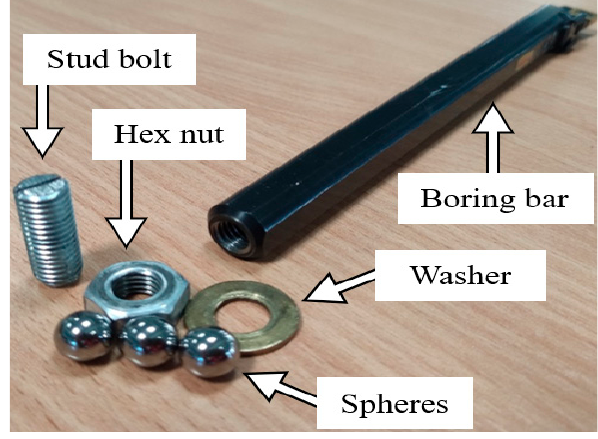
Figure 1. Impact Damper boring bar manufactured in the laboratory. Table 1. Main data of the tools with a constant diameter of 16 mm.